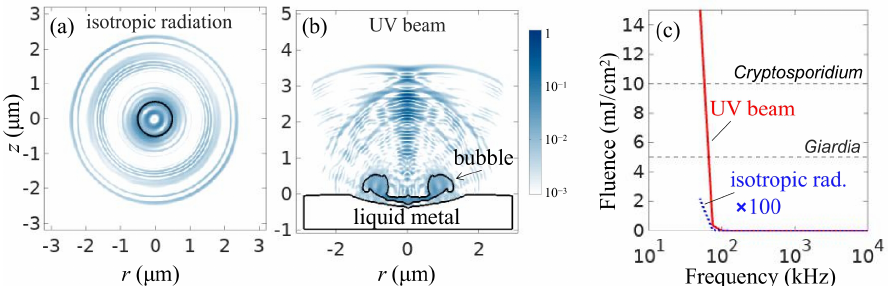
Figure 6. Spatial patterns of light emitted by ( a ) a spherical bubble in a bulk of water and ( b ) a non- spherical bubble near the liquid metal surface. The black curves outline the contours of the bubble and liquid metal surface. The equilibrium radius of the bubble is 1 µ m. ( c ) UV radiation fluence as a function of the ultrasound wave frequency f . The fluence of isotropic radiation is multiplied by 100. The fluence required for the inactivation of Giardia and Cryptosporidium pathogens is indicated. Reproduced from [39] under the terms of a Creative Commons